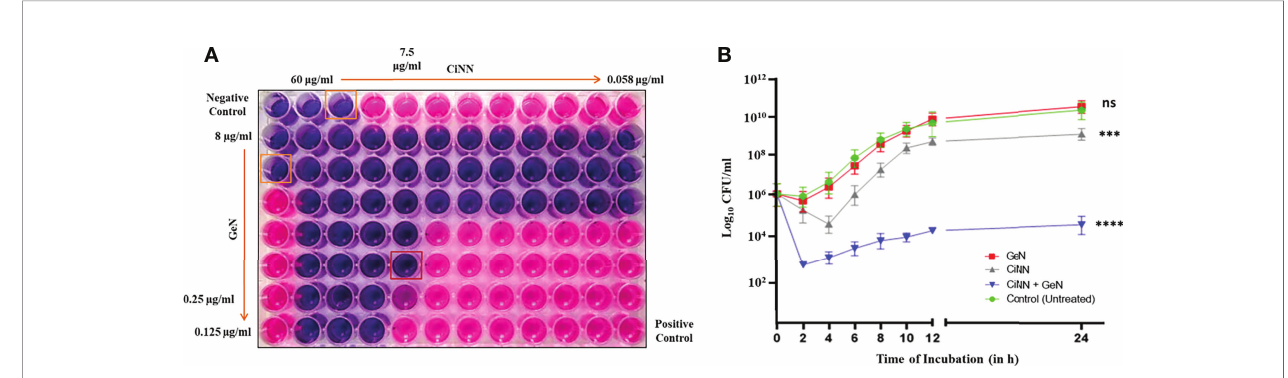
FIGURE 2 | Evaluating the synergism between CiNN and GeN against P. aeruginosa PAO1 using (A) the standard chequerboard assay and (B) time-kill kinetics assay. (ns, not signi fi cant, ***p ≤ 0.001, ****p ≤ 0.0001).